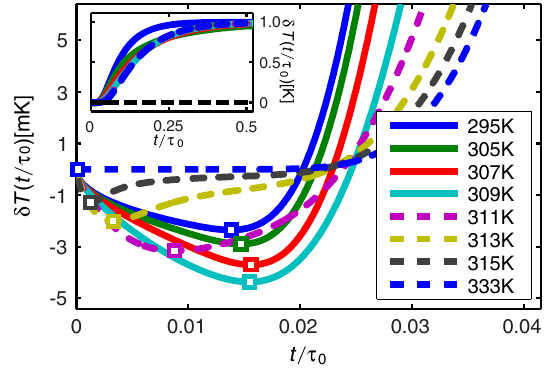
FIG. 8. The change in temperature (cid:5)T at the center of a sphere, after a temperature step of (cid:1) T ¼ 1 K has been applied at the surface. A model of the thermoviscoelastic relaxation of glucose with realistic limiting thermodynamic parameters has been in- voked. Time is scaled by the characteristic diffusion time (cid:1) which is 800 s for a glucose ball of radius 9.5 mm. The minimum of approximately (cid:2) 5 mK occurs for the 309 K curve just above T at 0 : 017 (cid:1) , corresponding to 14 s. Notice that although the g 0 cooling-by-heating phenomenon is present in the glassy solid state, it becomes more pronounced at the glass transition. The squares marking the minima at each temperature are plotted against temperature in Fig.